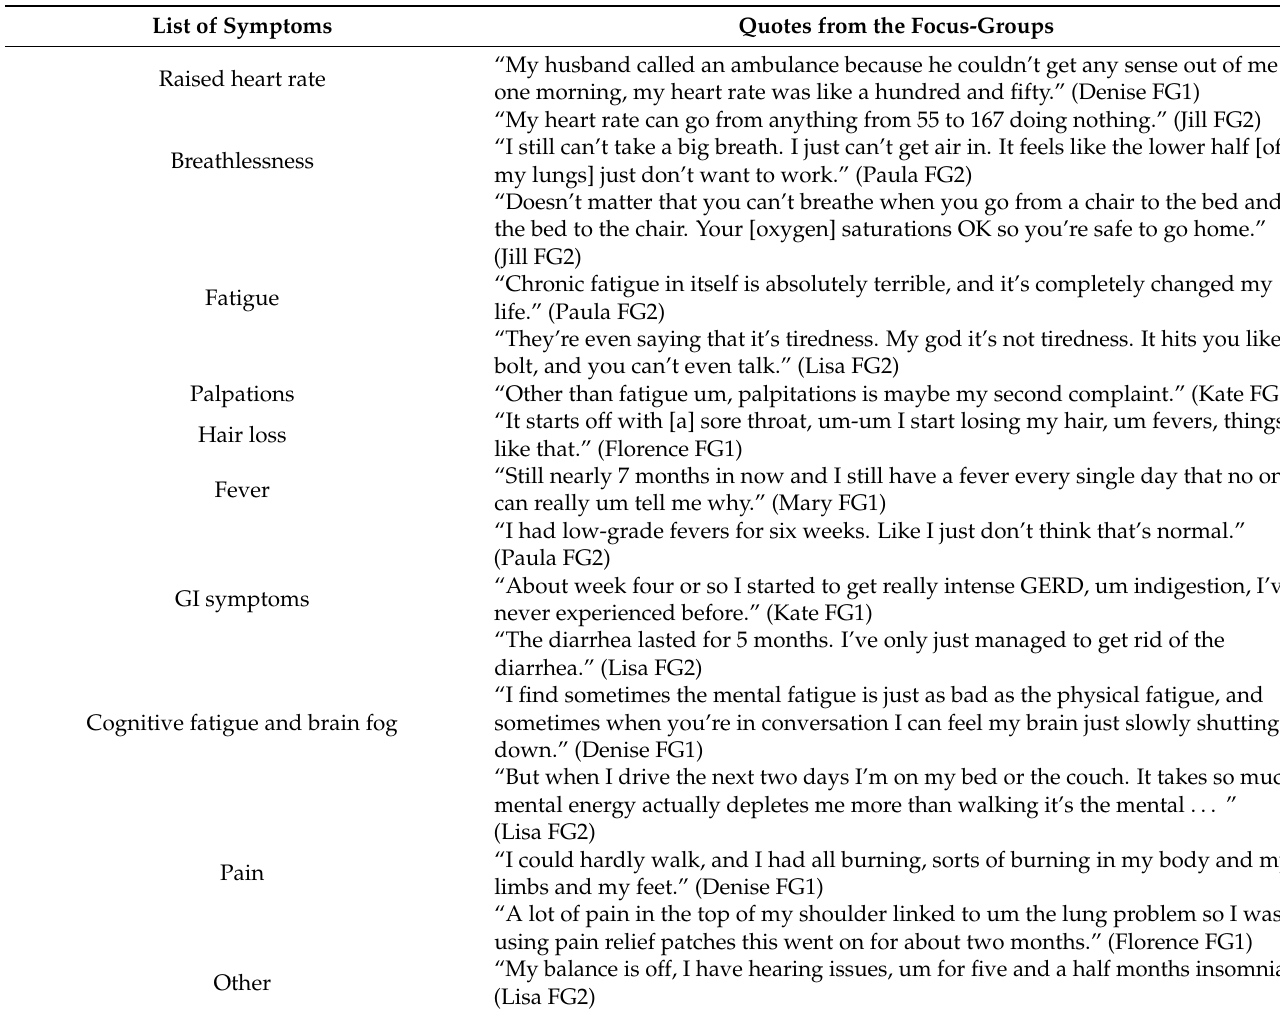
Table 1. A list of symptoms experienced by participants. List of Symptoms Quotes from the